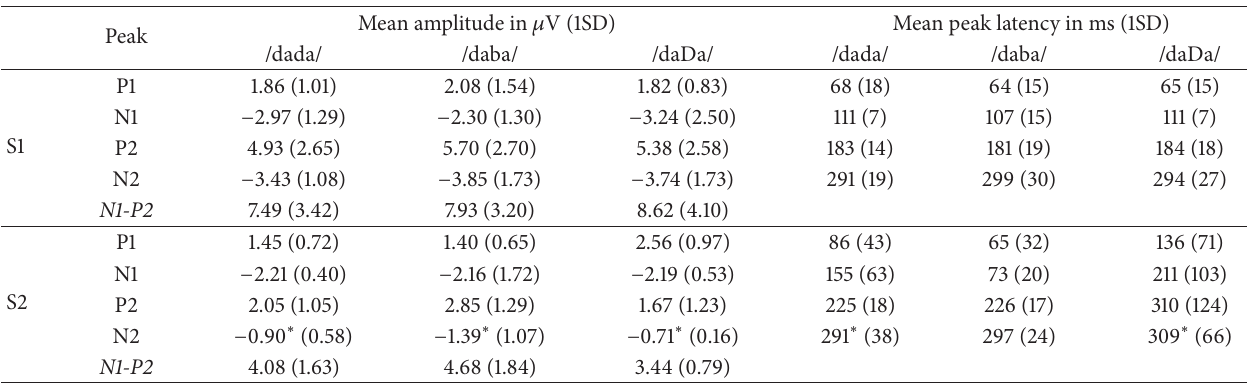
Table 2: Adults: mean (1SD) baseline-to-peak amplitude and peak latency measurements for individual components of the waveform elicited to the S1 and S2 portion of the /dada/, /daba/, and /daDa/ stimulus conditions are shown. The latencies were measured from the onset of the S1 stimulus and from the onset of the change in the stimulus at S2. Mean (1SD) N1-P2 amplitudes are also indicated. Mean values that represent measurements from fewer than five responses are denoted with an asterisk ( ∗ ). The dashed line indicates that no responses were detected. The terms “BP” and “BN” denoted “broad positive” and “broad negative” peaks, respectively.